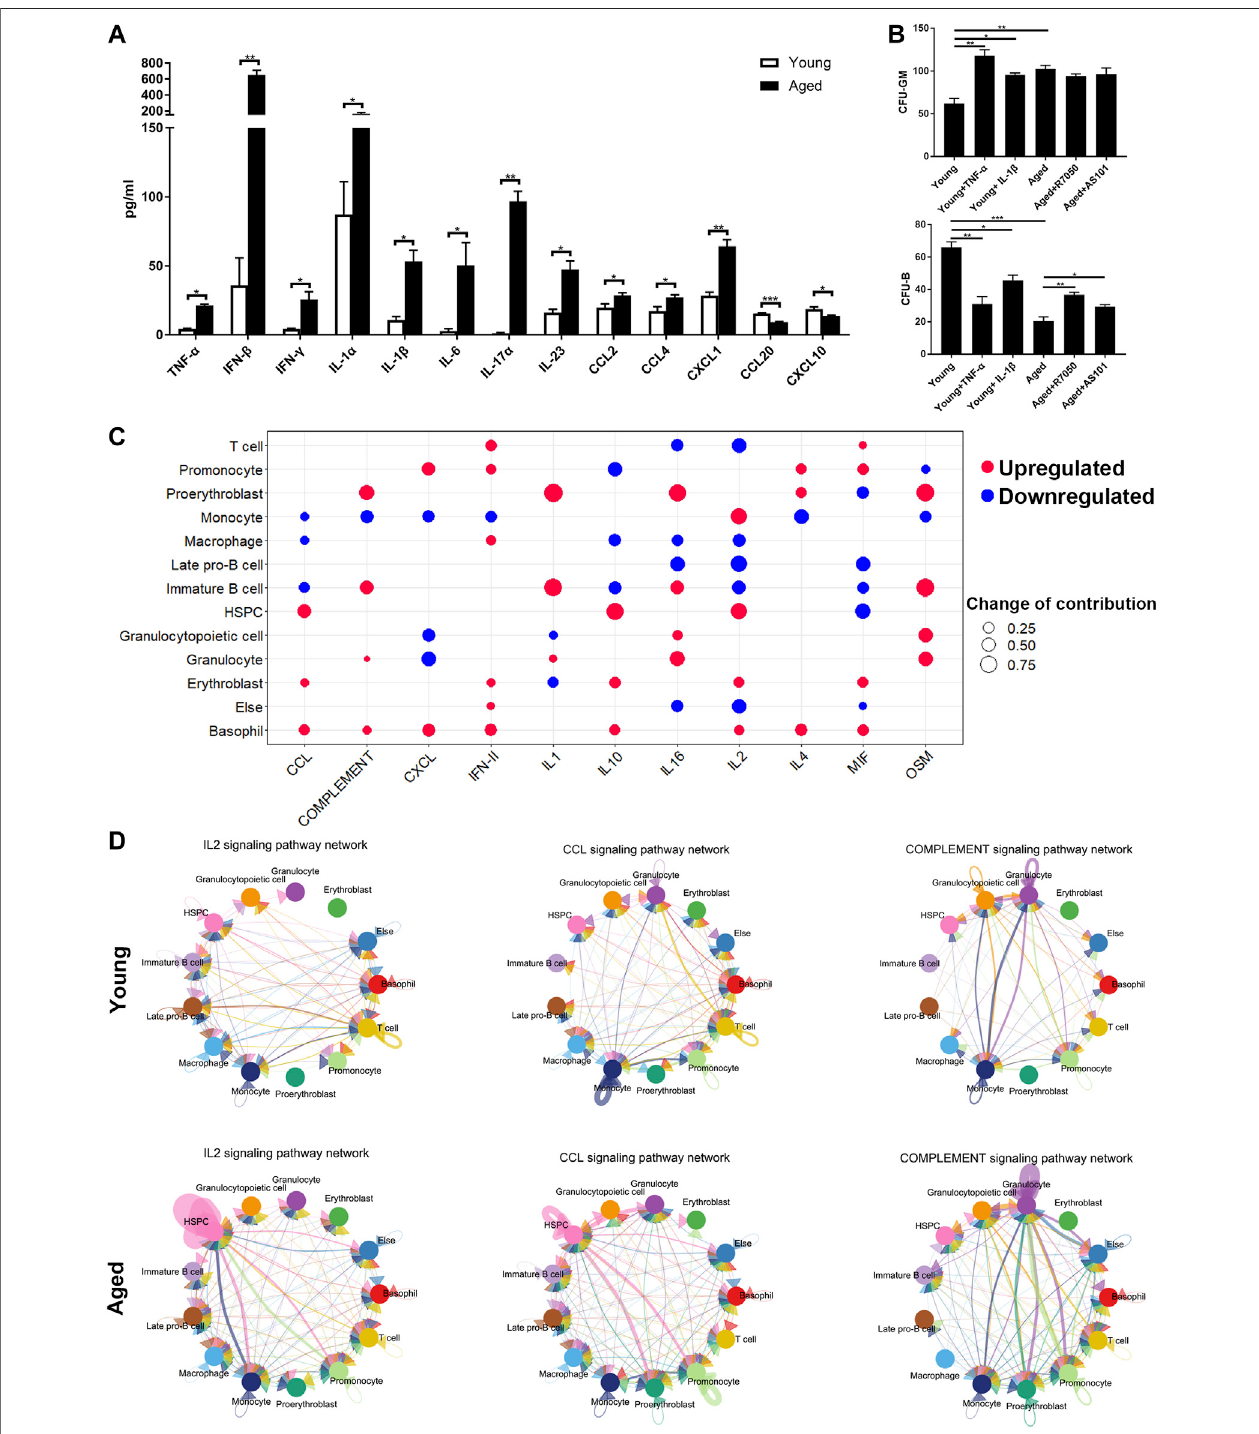
FIGURE 6 | In fl ammatory cytokines and chemokines in the bone marrow niche. (A) Quantitation of in fl ammatory cytokines and chemokines in young and aged bonemarrownichesviaaCytoplexAssay.Dataarepresentedasthemean ± SEM.* p < 0.1;** p < 0.01;*** p < 0.001. (B) Ganulocyte/macrophage(GM)andBcellcolony formationwasmeasured foryoungoragedHSPCsincubatedfor10 daysinmethylcelluloseinthepresenceofeitherDMSOvehicleorIL-1 β (25 ng/ml),TNF- α (1 μ g/ml), AS101 (2 μ g/ml, IL-1 β inhibitor) and R7050 (2 μ g/ml, TNF- α receptor antagonist). Graph shows mean ± SEM. (C) Dot plots showing the differences in the contribution to different in fl ammatory signaling pathways. Upregulated cytokines and chemokines are marked in red and downregulated cytokines and chemokines are marked inblue. Thesize ofthe dots represents thechangein contribution. (D) Circle plot ofthe cell-cell communication networkshowing thatthe in fl ammatorypathway network (IL2, CCL and complement signaling pathways) became more complex and interconnected in the aged bone marrow niche.